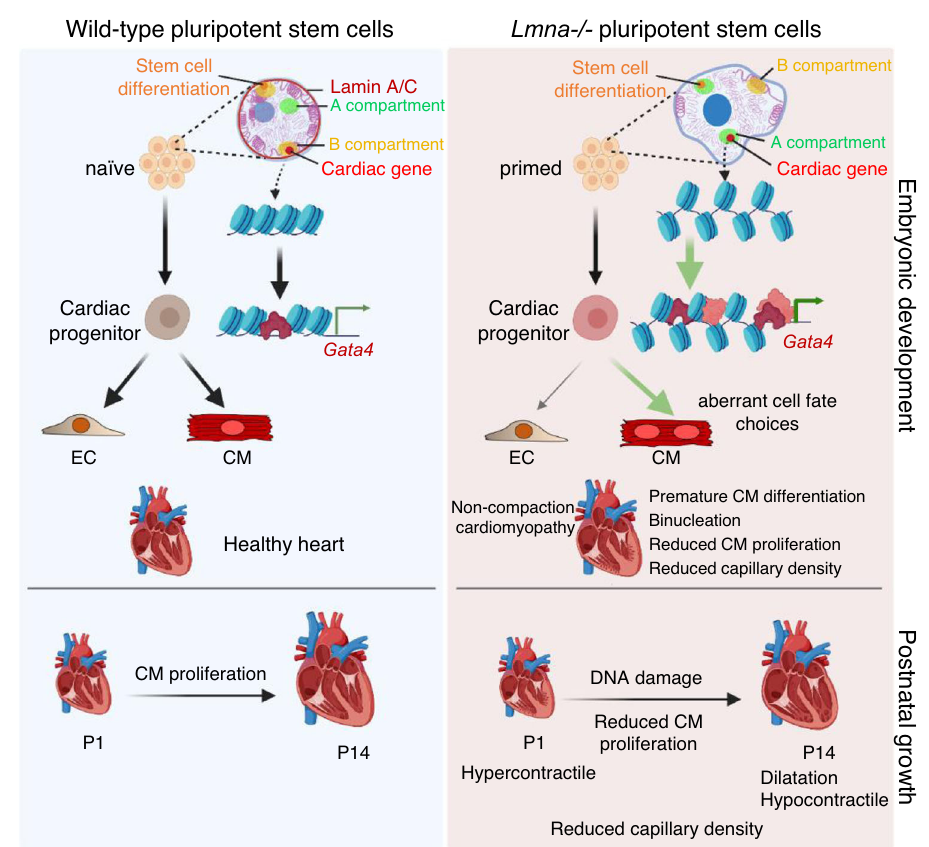
Fig. 10 | Key function of lamin A/C in naïve pluripotent stem cells for cardiac development and disease. In naïve pluripotent stem cells, lamin A/C tethers cardiac-speci fi c genes and genes involved in stem cell differentiation to the repressive nuclear periphery. Lamin A/C loss leads to their dissociation from the nuclearlaminaaccompaniedbymajorchromatinreorganizationresultingineither ectopicexpressioninmESCs(e.g., Gata4 , Myl4 )orepigeneticprimingforactivation